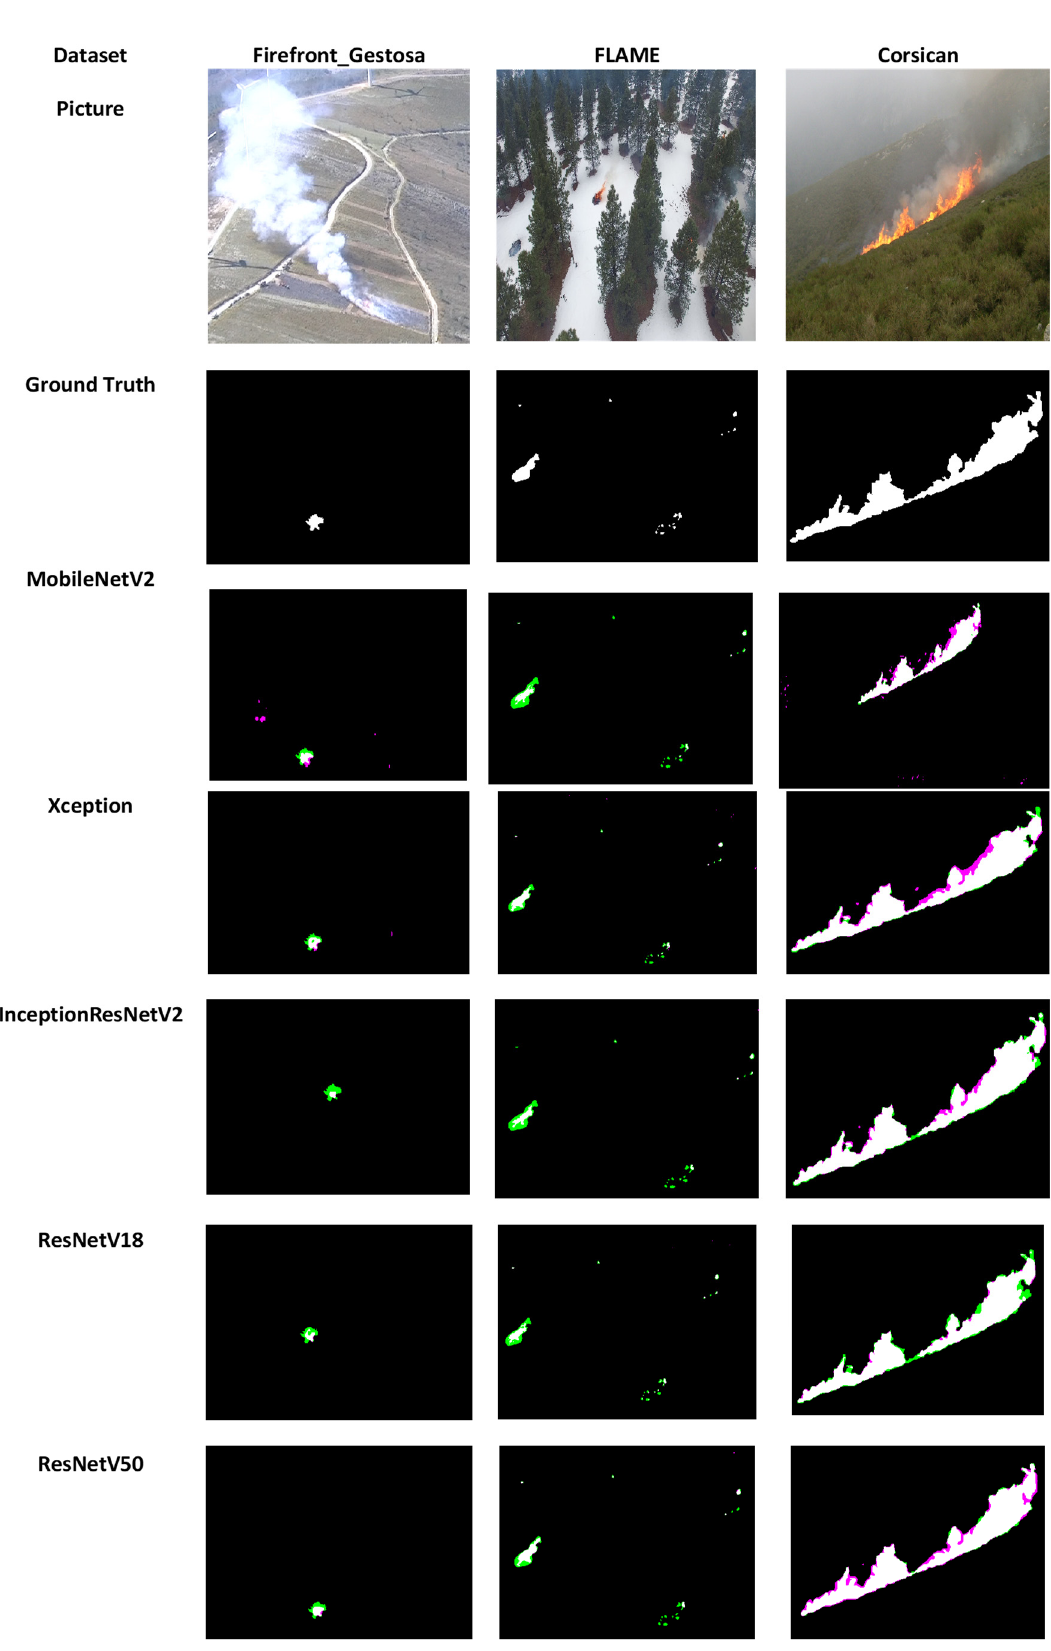
Figure 12. Example of segmentation of a picture of every dataset: The first, second, and third columns are result examples from Firefront_Gestosa, FLAME, and Corsican data, respectively. The first and second rows are the pictures and their corresponding ground truths. The rows from three